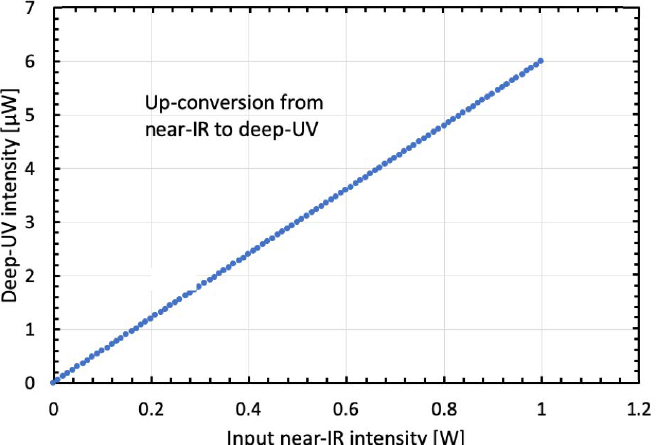
Figure 4. Calculated output intensity at an energy corresponding to the AlN bandgap of 6.2 eV ( λ = 200 nm) as a function of optical illumination at λ = 1.55 µ m. For the available range of input intensities, no pronounced saturation effects are to be